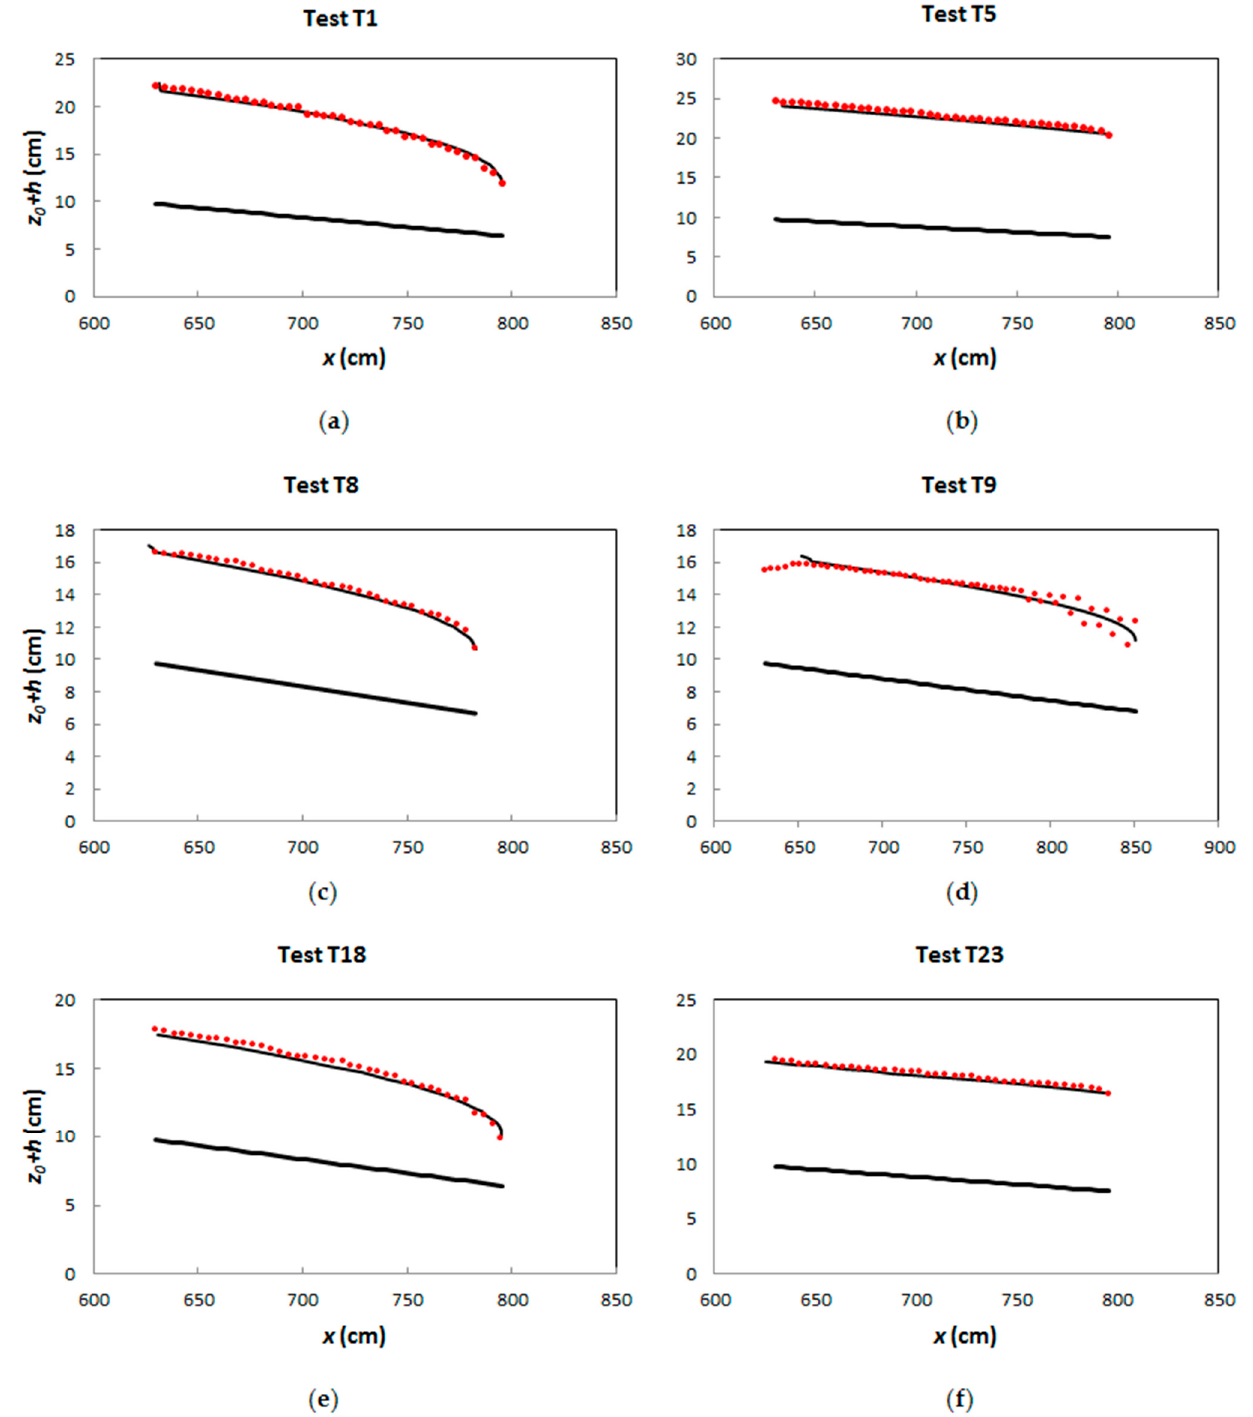
Figure 10. Comparison between the measured and the calculated free surface profiles obtained using C D − UC : ( a ) T1; ( b ) T5; ( c ) T8; ( d ) T9; ( e ) T18; ( f ) T23. The black bold line indicates the flume bottom; the black line is the calculated free surface; the red symbols indicate the measured free surface.